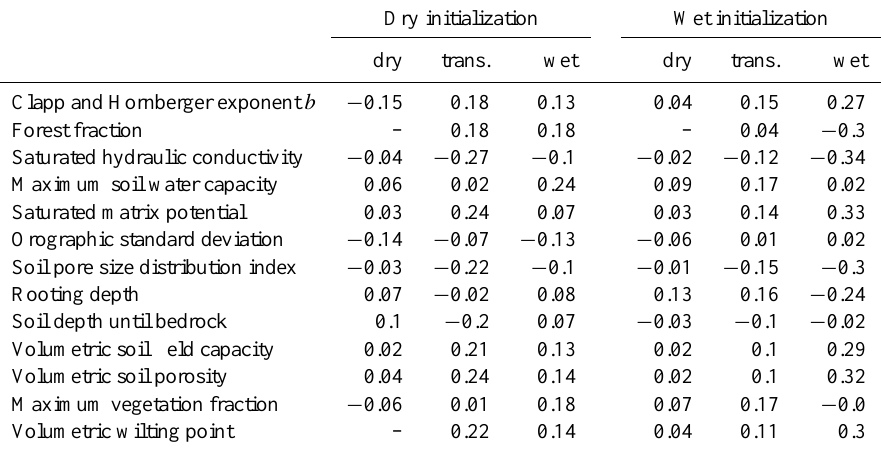
Table 4. Spatial December ensemble rank correlation coefficients between soil moisture τ 0 and static soil properties for different soil moisture regimes and initializations. Note that all correlations during this season are insignificant ( p > 0 .